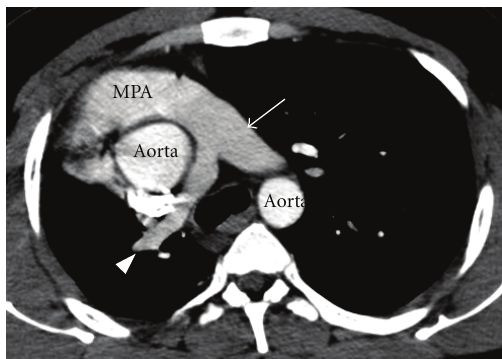
Figure 2: CT angiography axial image depicts smaller calibre right pulmonary artery (arrow head), normal calibre left pulmonary artery (thin arrow), main pulmonary artery (MPA).